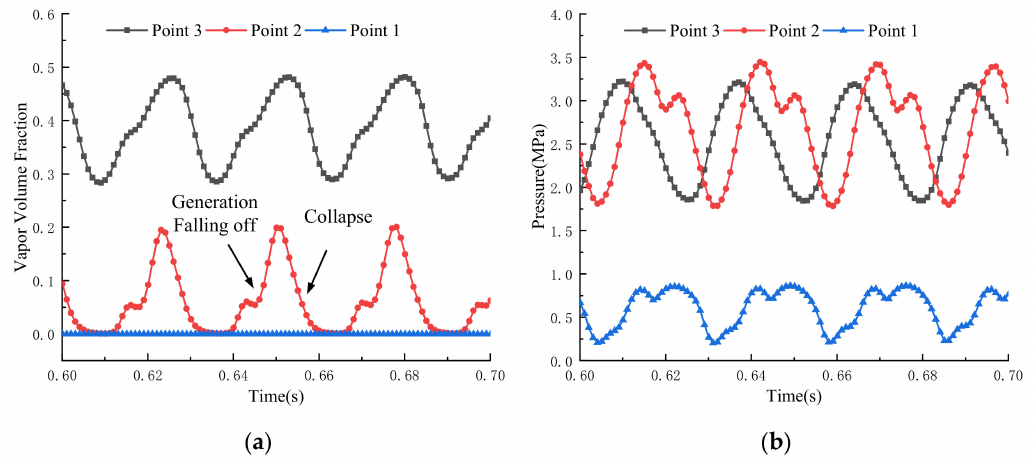
Figure 7. Fluctuations of local parameters at the monitoring points: ( a ) Local cavitation fraction; ( b )